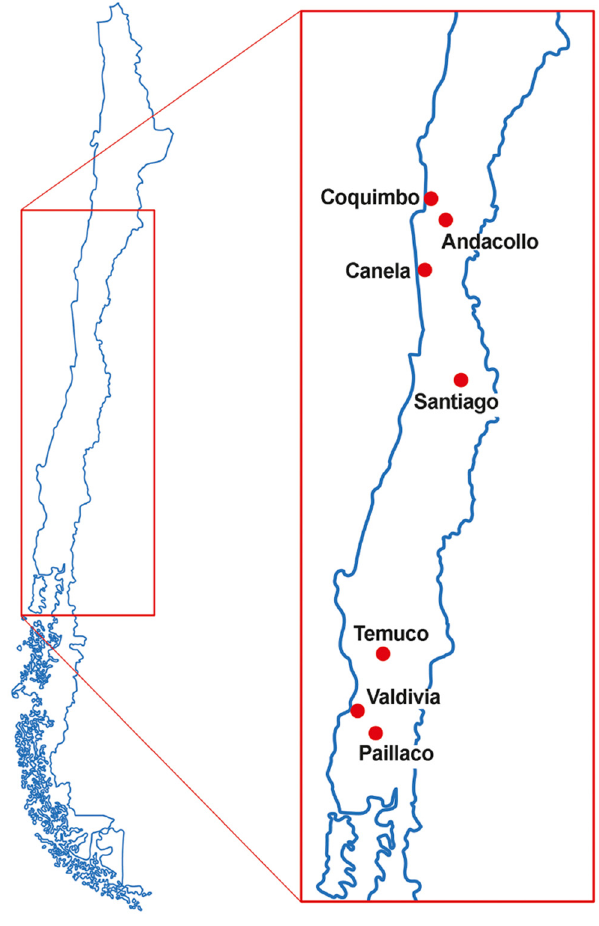
Figure 1. Map of Chile showing the location of the clinics.